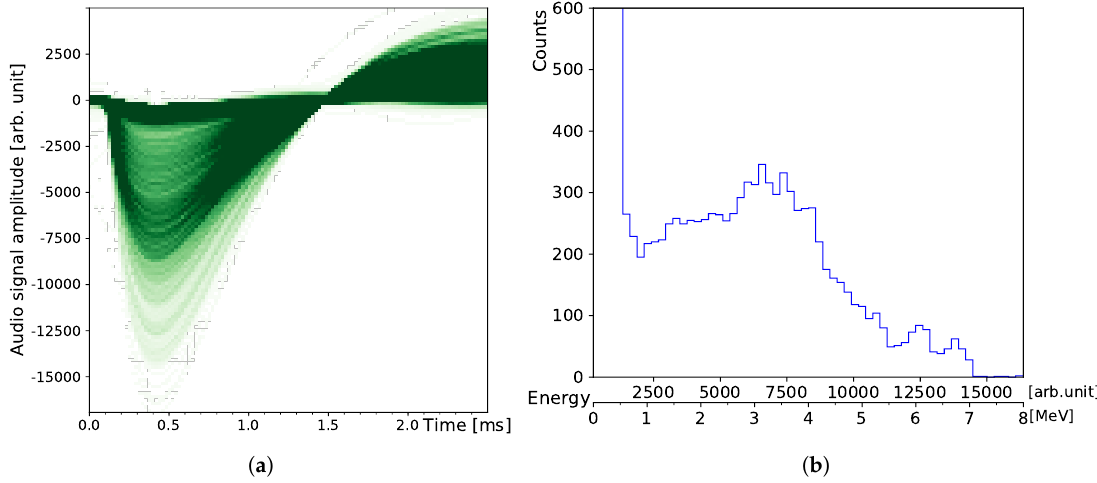
Figure 9. Measurement of a radioactive columbite stone using the DIY particle detector: Compared to Figure 7a, the 56,147 detected pulses cover a much larger spectrum of values. The pulses on the left Figure ( a ) are superimposed using transparent ink in order to reveal an alternative representation of the maximum pulse amplitude distribution depicted in the energy histogram on the right ( b